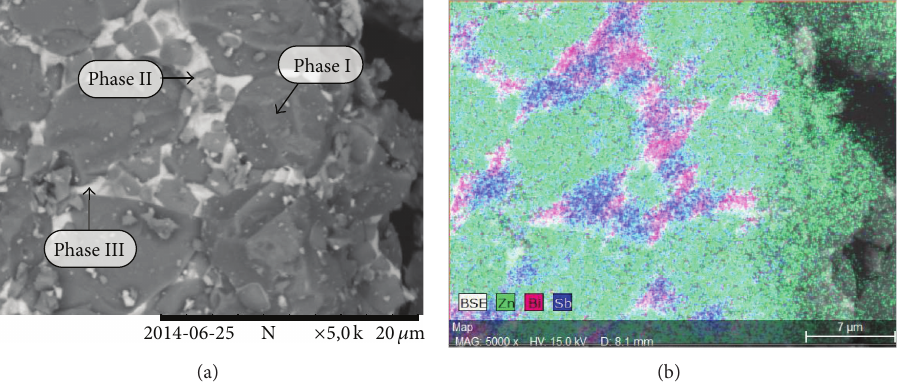
Figure 1: (a) SEM micrograph of pulverized MOV prior to leaching depicting three phases present: (I) ZnO grains, (II) Sb-rich phase, and (III) Bi-rich phase. (b) EDX map of varistor material seen in Figure 1(a) with zinc, bismuth, and antimony-rich phases.